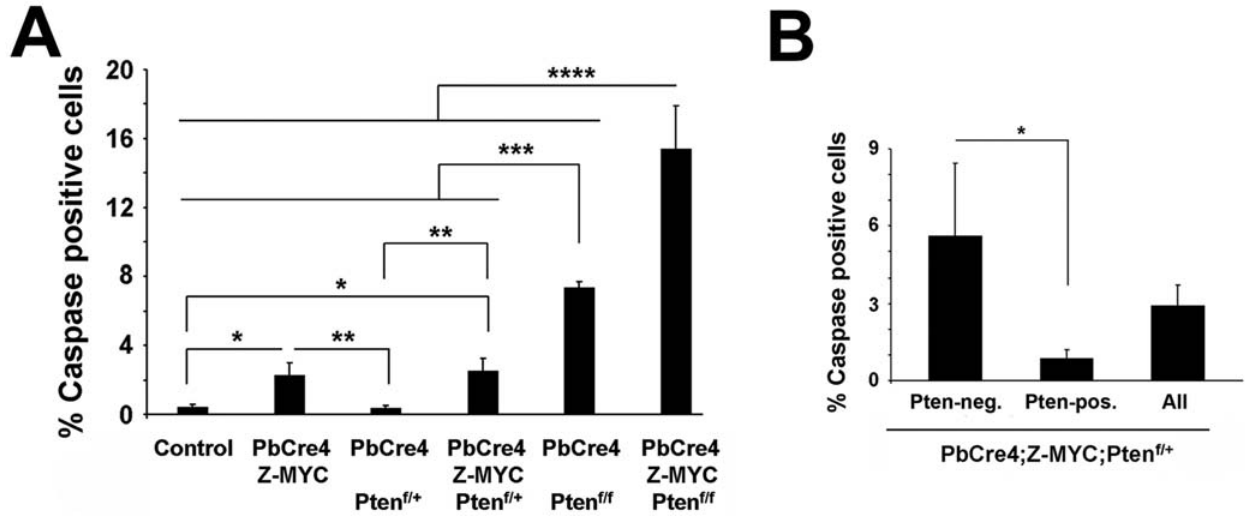
Figure 6. Analysis of apoptosis in c-MYC/Pten compound mutant mice. (A) Apoptosis was analyzed by staining for activated Caspase 3. (B) Sections from PbCre4;Z-MYC;Pten f/ + prostates were doubly stained for activated Caspase 3 and Pten, and the number of apoptotic cells was quantitated in Pten-positive and Pten-negative epithelial cells. N=3–4 mice per group. * p , 0.05, ** p , 0.005, *** p , 0.001 and **** p , 0.01.